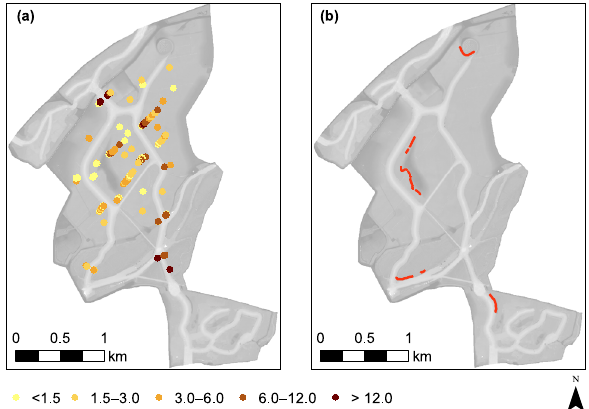
Figure 6. The total sedimentation (cm) in the subtidal and intertidal area (a) and the location of the cut banks (b) as measured during field campaigns of 2014.